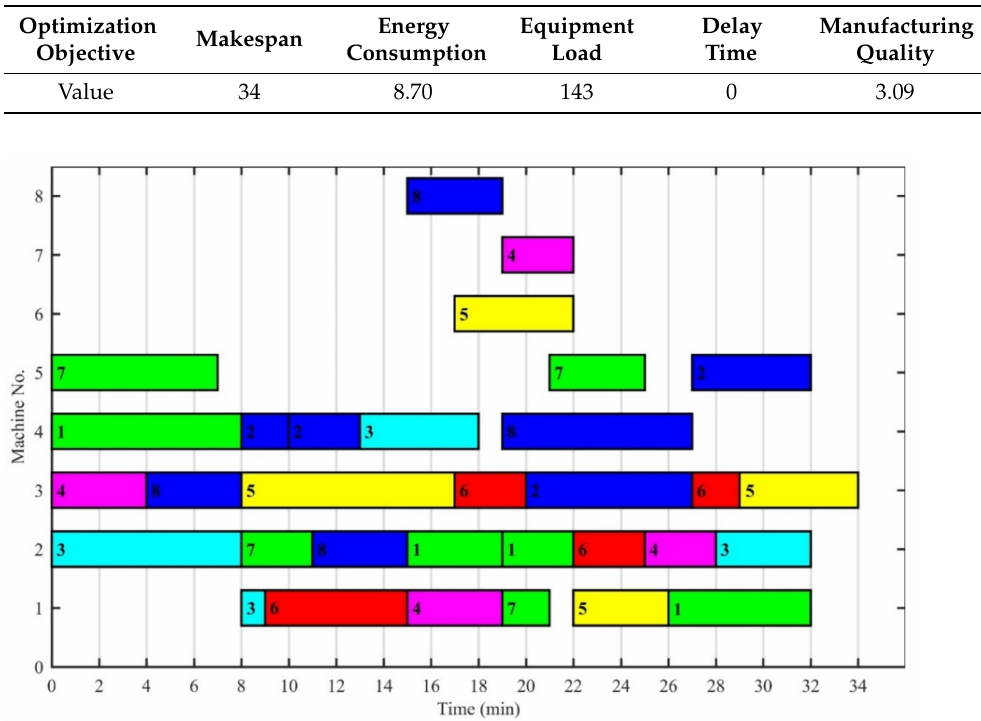
Table 10. The best compromise solution of the engineering case.